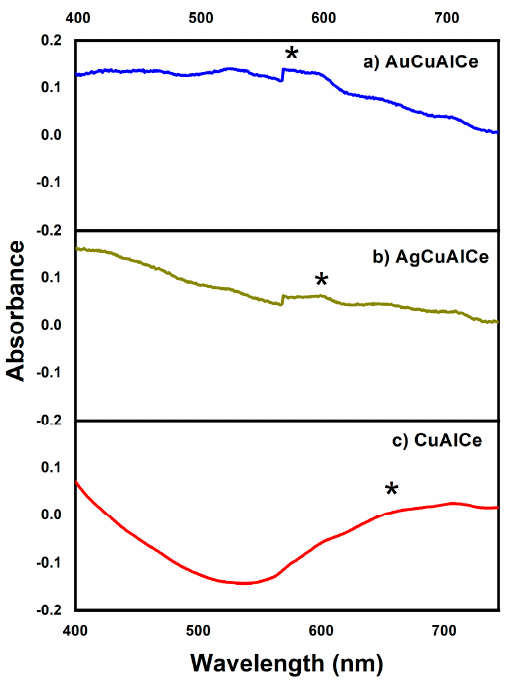
Figure 3. DR-UV-Vis spectra of AuCu and AgCu catalysts ( a , b ) and Cu-supported monometallic catalyst ( c ). Surface Plasmon Resonance: (*) SPR.